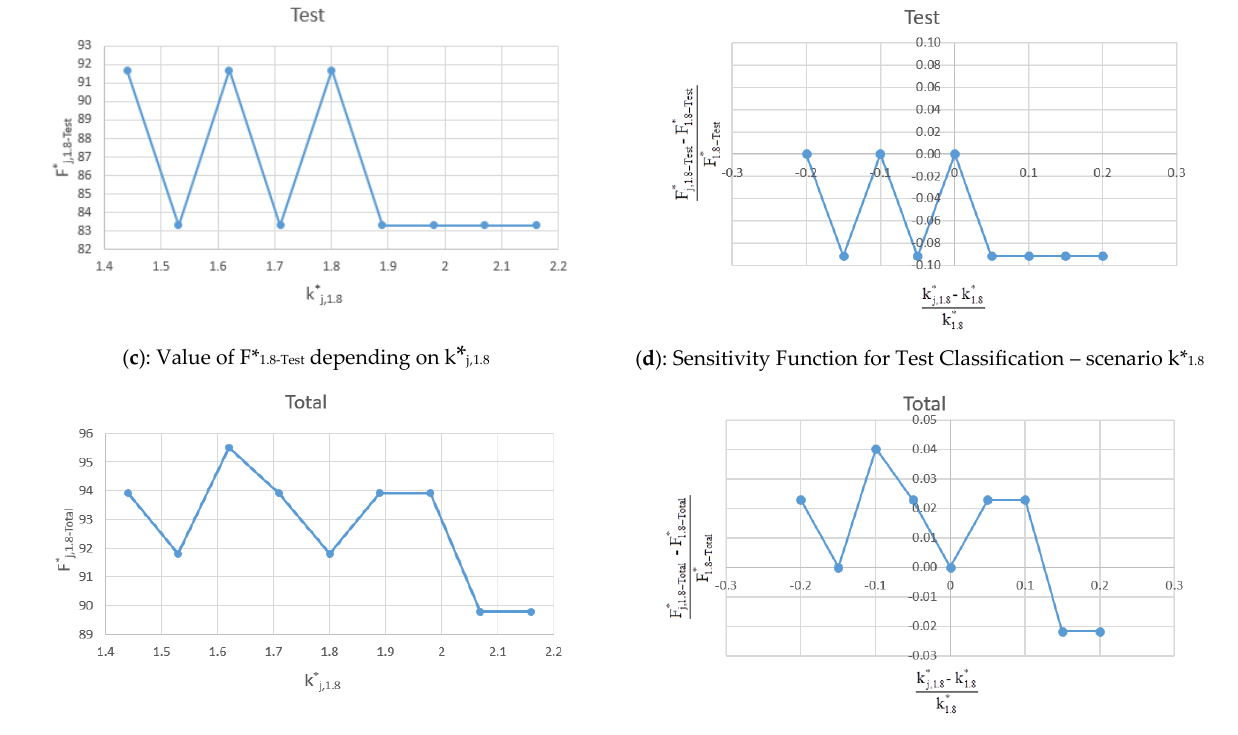
Figure 11. Values of F* j,1.8-Train , F* j,1.8-Test, and F* j,1.8-Total and sensitivity function for the scenario with k* 1.8 .